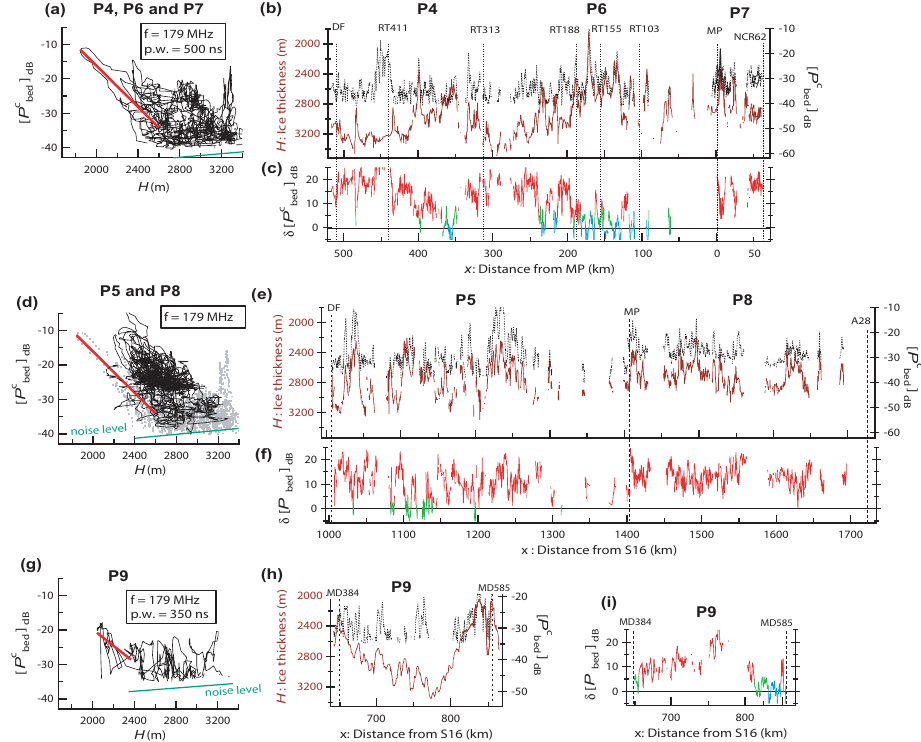
Fig. 5. Results for series P legs. (a) H-P plot along legs P4, P6, and P7. The red line is the regression line for H < 2600m. (b) X-PH plot for the same data. (c) X- δ P plot for the same data. (d) H-P plot along legs P5 and P8. The grey dots in the background indicate the results for the neighbouring legs P4, P6, and P7 for comparison. (e) X-PH plot for the same data. (f) X- δ P plot for the same data. (g) H-P plot for leg P9. The red line is the regression line to a depth of 2360m. (h) X-PH plot for the same data. (i) X- δ P plot for the same